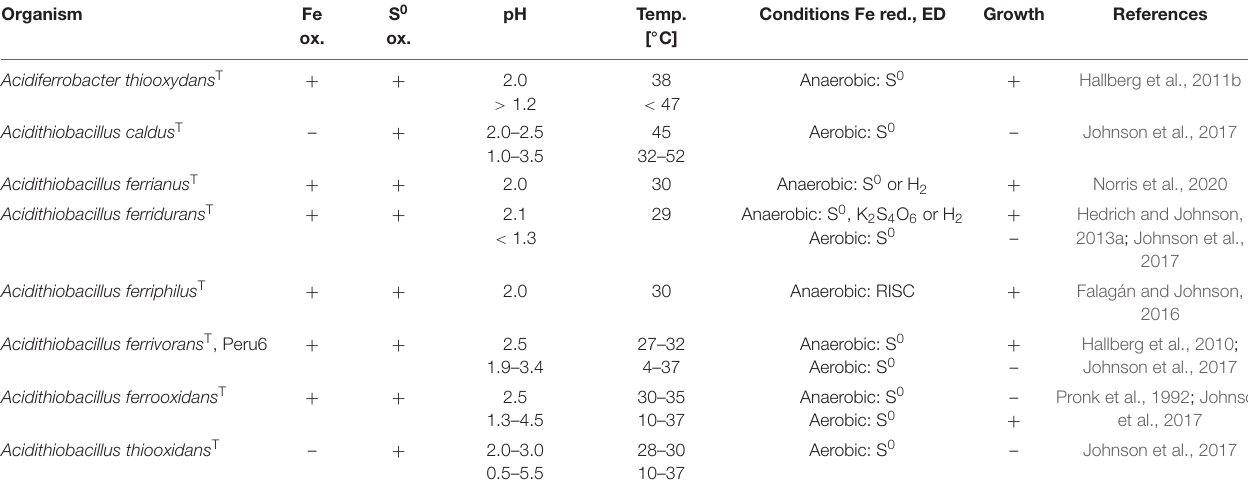
TABLE 3 | Ferric iron-reducing extreme acidophilic autotrophic bacteria. Organism Fe